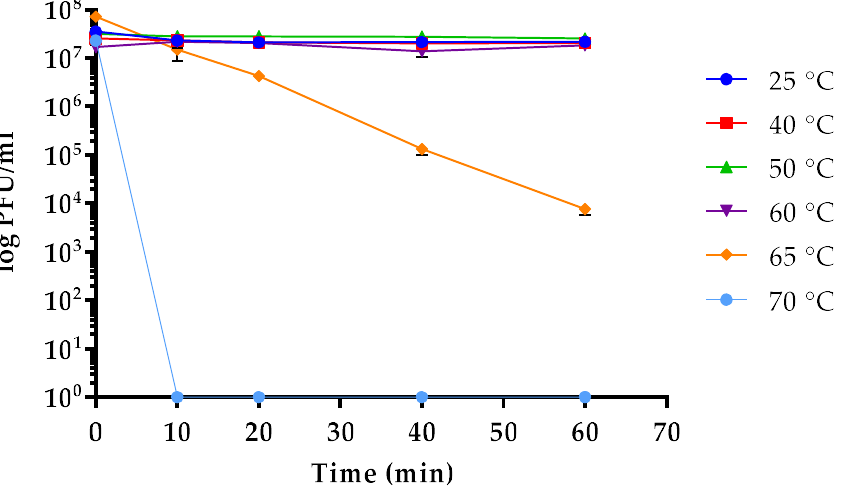
Figure 3. Thermal stability of vB_Kpn_F48. Each data point is the mean from three experiments. Standard deviations are shown as vertical lines.